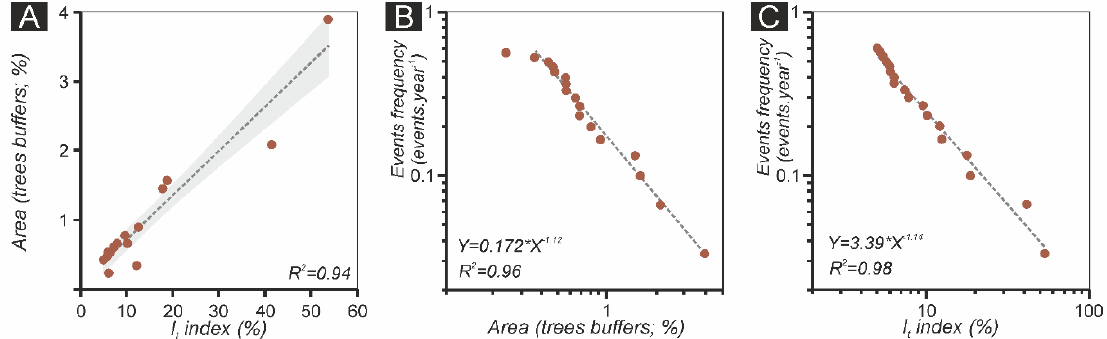
Figure 6. The magnitude–frequency relationships of the L’ubietov á landslide, and the relationships among the methods of expressing magnitude (( A )—relationships for I t index and trees bu ff ers, ( B )—M-F for trees bu ff ers based area, ( C )—M-F for I t